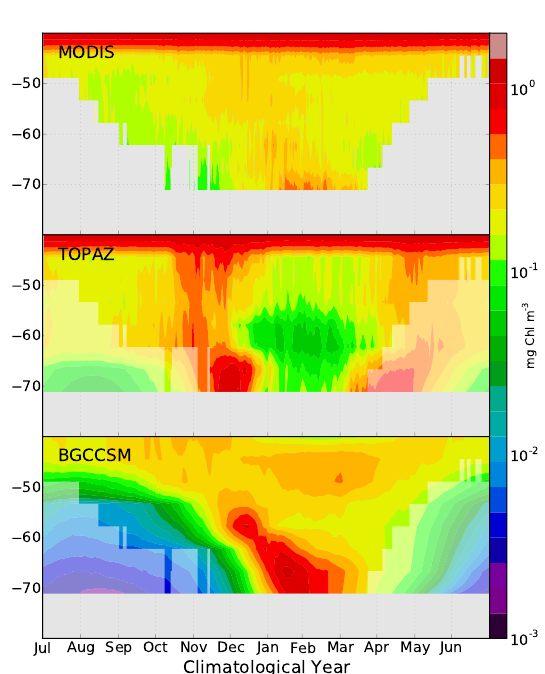
Figure 3. Hofmøller plots of satellite Chl (top panel), Chl simulated by TOPAZ (middle panel), and Chl simulated by BGCCSM (bottom panel) south of South Africa. All panels are zonal medians within the box. All data that fall on a specific grid cell on a specific day of the year are averaged to one